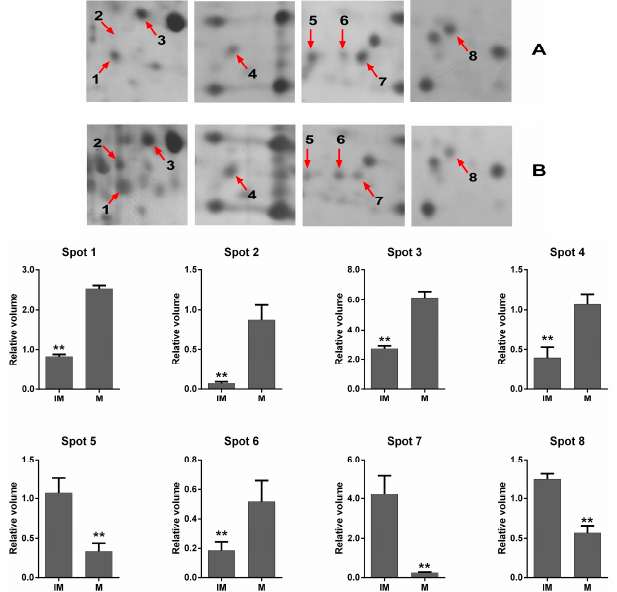
Figure 2. Magnified maps of differentially expressed protein spots and statistical analysis. ( A ) The magnified 2-DE maps from immature oocytes; ( B ) the magnified 2-DE maps from mature oocytes.IM: immature oocyte; M: mature oocyte. Spot 1: IM (0.82 ± 0.06) vs. M (2.54 ± 0.08); Spot 2: IM (0.07 ± 0.02) vs. M (0.87 ± 0.16); Spot 3: IM (2.71 ± 0.20) vs. M (6.16 ± 0.41); Spot 4: IM (0.39 ± 0.14) vs. M (1.07 ± 0.13); Spot 5: IM (1.08 ˘ 0.19) vs. M (0.34 ˘ 0.10); Spot 6: IM (0.19 ˘ 0.06) vs. M (0.51 ˘